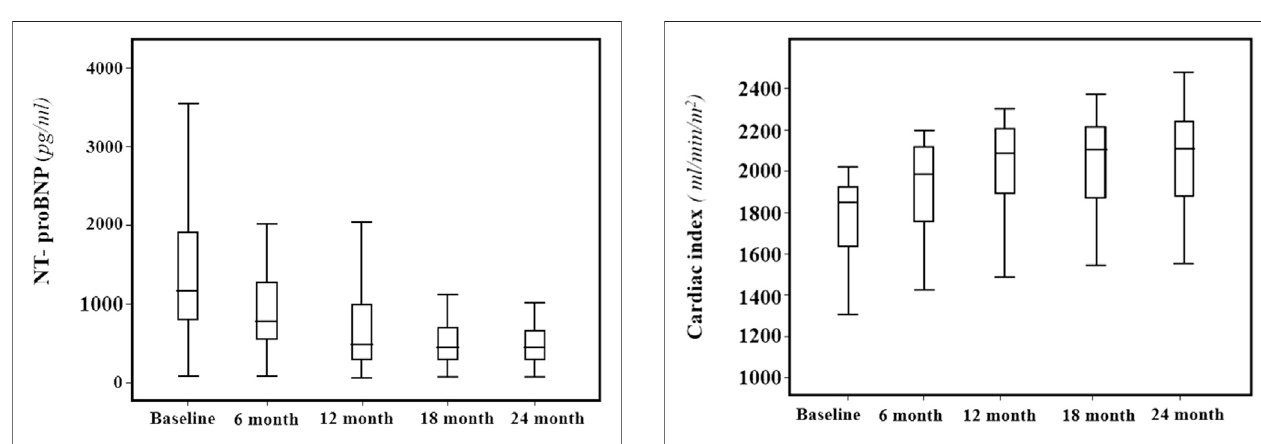
FIGURE 2 | Mean values and standard deviation of the Cardiac Index (ml/min/m 2 ) at baseline and every 6 months, during the 24-months follow-up.